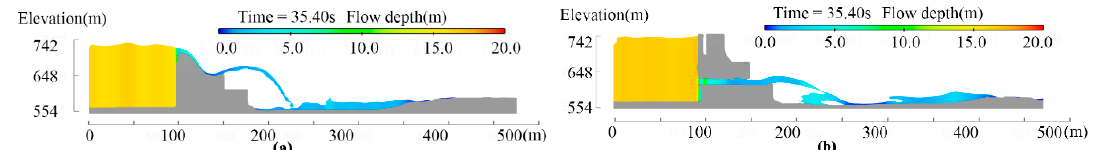
Figure 9. Dam discharge flow profile. ( a ) dam discharge through the surface spillway; ( b ) dam discharge through the bottom outlet.